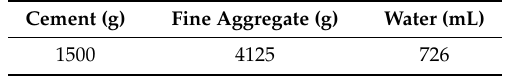
Figure 1. Mortar specimen: ( a ) coating of steel bar, ( b ) an acrylic mold, ( c ) top view, and ( d ) side view. Table 3. Details of mix; cement-mortar